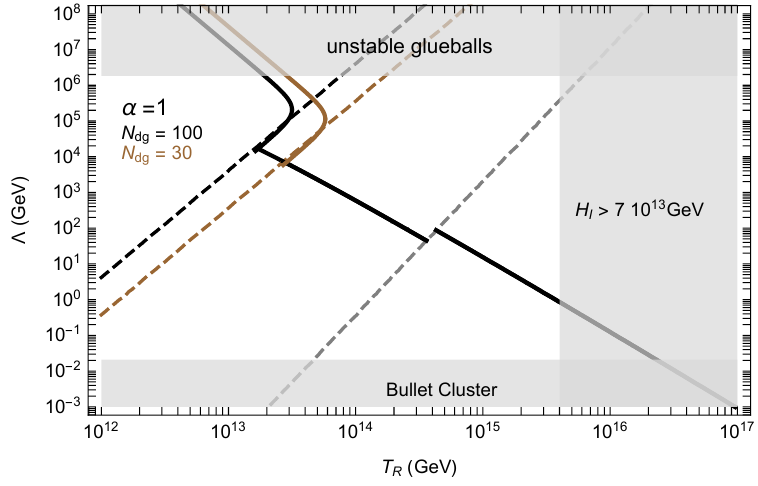
Figure 1 . Phase diagram of gravitationally produced glueball DM. DM abundance is reproduced on the black and brown lines. In the lower right region below the dashed grey line gluons thermalise in the relativistic regime and then undergo cannibalism, reducing their numerical abundance. In the middle region between dashed lines gluons confine before thermalisation but glueballs then thermalise. In the upper left region above the dashed lines the system never thermalises and the abundance depends on N DG (black and brown lines). The grey regions are excluded by DM self- interaction, scale of inflation and lifetime of glueballs where we use the estimate τ DG ∼ M 4